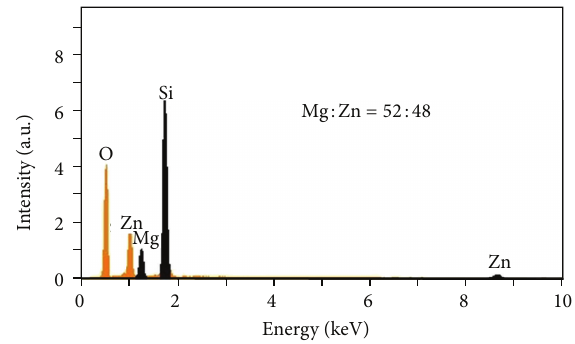
Figure 4: EDS spectrum of the Mg 𝑥 Zn 1−𝑥 O thin film.